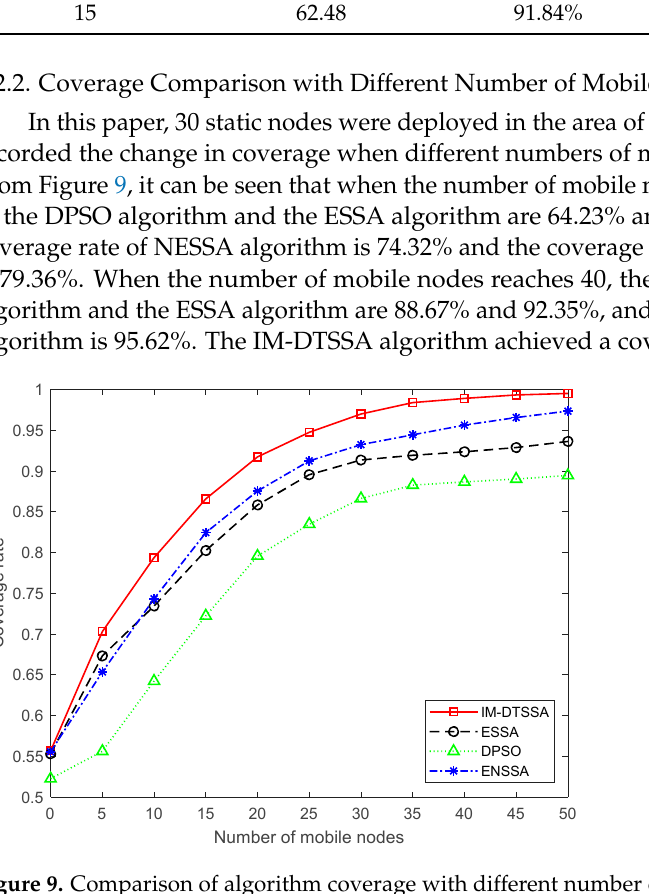
Figure 9. Comparison of algorithm coverage with di ff erent number of mobile nodes.